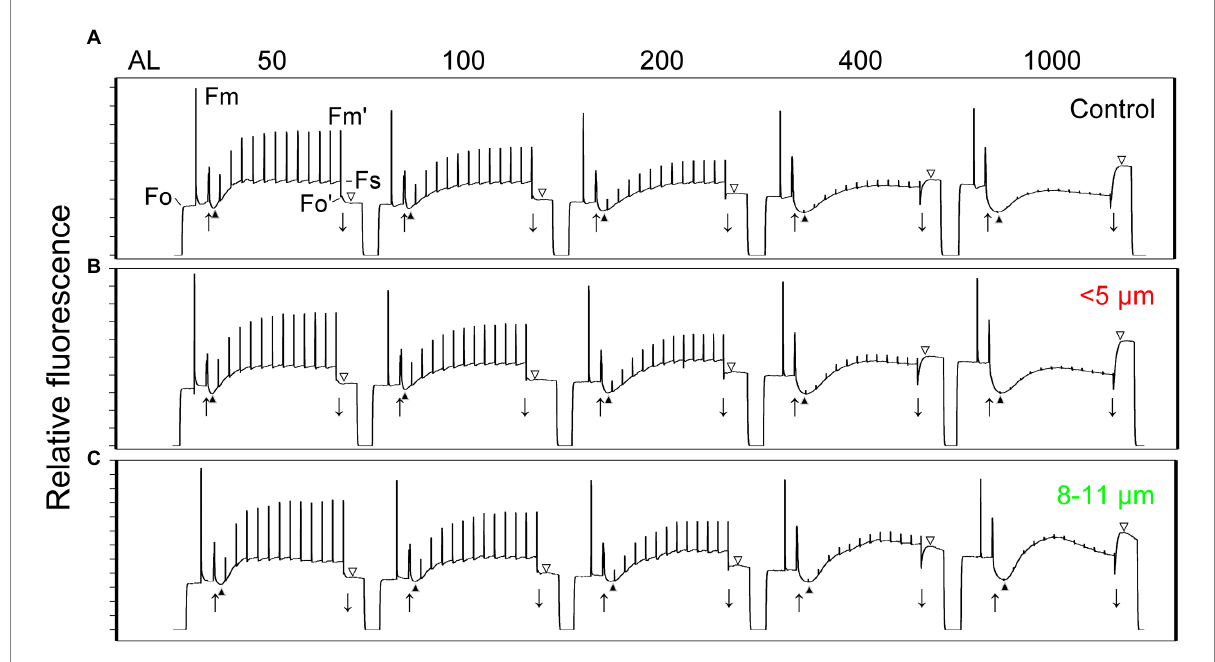
FIGURE 6 Chlorophyll fluorescence light response traces of C. priscuii control cells (A) and separated cell fractions: <5 μ m (B) and 8–11 μ m (C) . Cultures were measured at increasing actinic light (AL) intensities of 50, 100, 200, 400, and 1,000 μ mol photons m − 2 s − 1 . ( ↑ ) Actinic light on. ( ↓ ) Actinic light off. Fluorescence quenching during the onset of actinic light [Fo- ▲ ], and post-illumination rise [ ▼ -Fo’]. Cells were dark adapted for 15 min prior to collection of the fluorescence